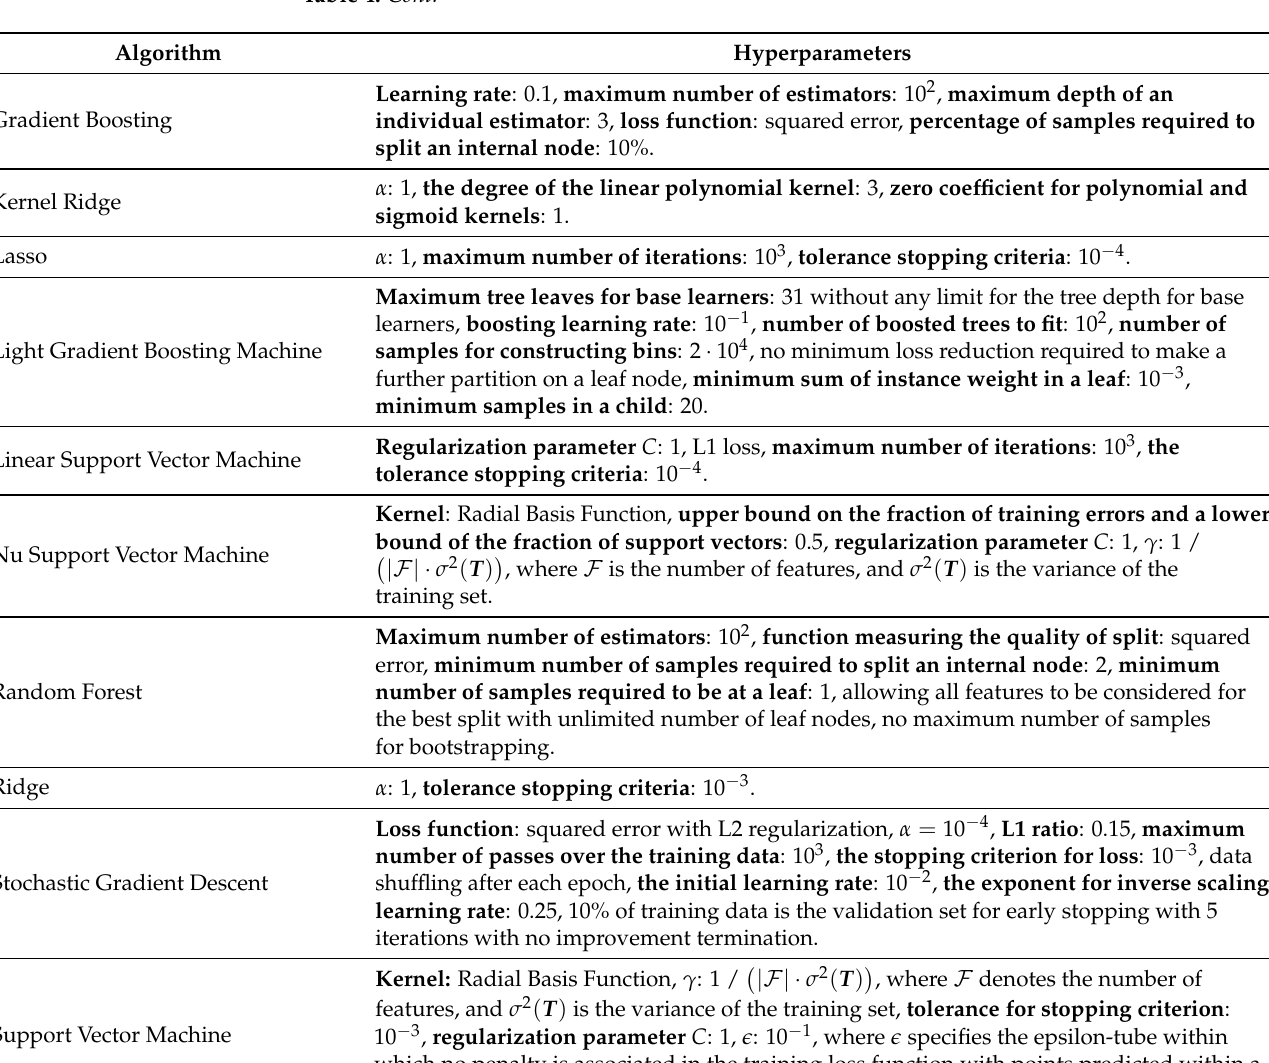
Table 4. Cont. Algorithm